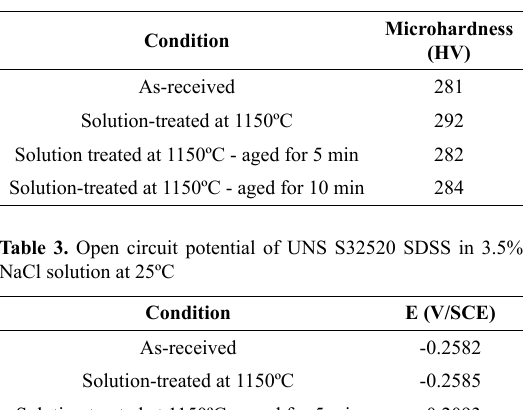
Figure 2. XRD patterns of the sample. (a) as-received; (b) solution-treated at 1150°C; (c) solution-treated at 1150°C and aged at 850ºC for 5 min., (d) solution-treated at 1150°C and aged at 850ºC for 10 min Table 2. Microhardness values of UNS S32520 SDSS